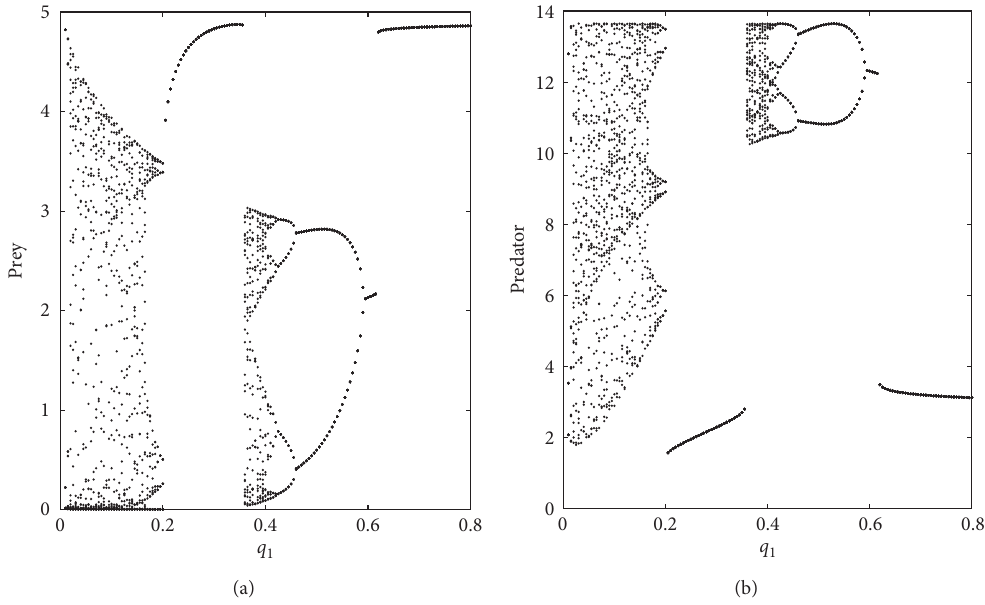
Figure 6: Bifurcation diagrams of model (1) with respect to q 0 . 55 , β � 0 . 87 , δ � 0 . 34 , θ